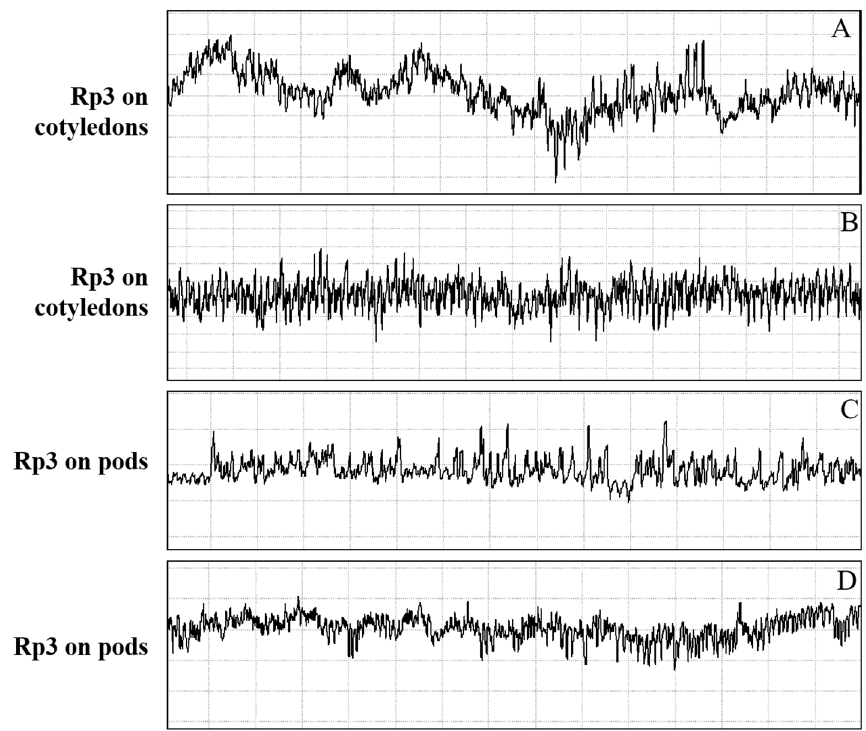
Figure 4. Detail of the waveform Rp3 recorded during feeding behavior of R. pedestris on soybean cotyledon and pod. ( A ) Amplitude of Rp3 waves and peak orientation recorded on cotyledons with relative amplitude ( − 3.8– − 2.4). ( B ) Amplitude of Rp3 waves and peak orientation recorded on cotyledons with relative amplitude ( − 2.4– − 1.8). ( C ) Amplitude of Rp3 waves and peak orientation recorded on pods with relative amplitude ( − 4.5– − 3.5). ( D ) Amplitude of Rp3 waves and peak orientation recorded on pods with relative amplitude (0.8–1.2).